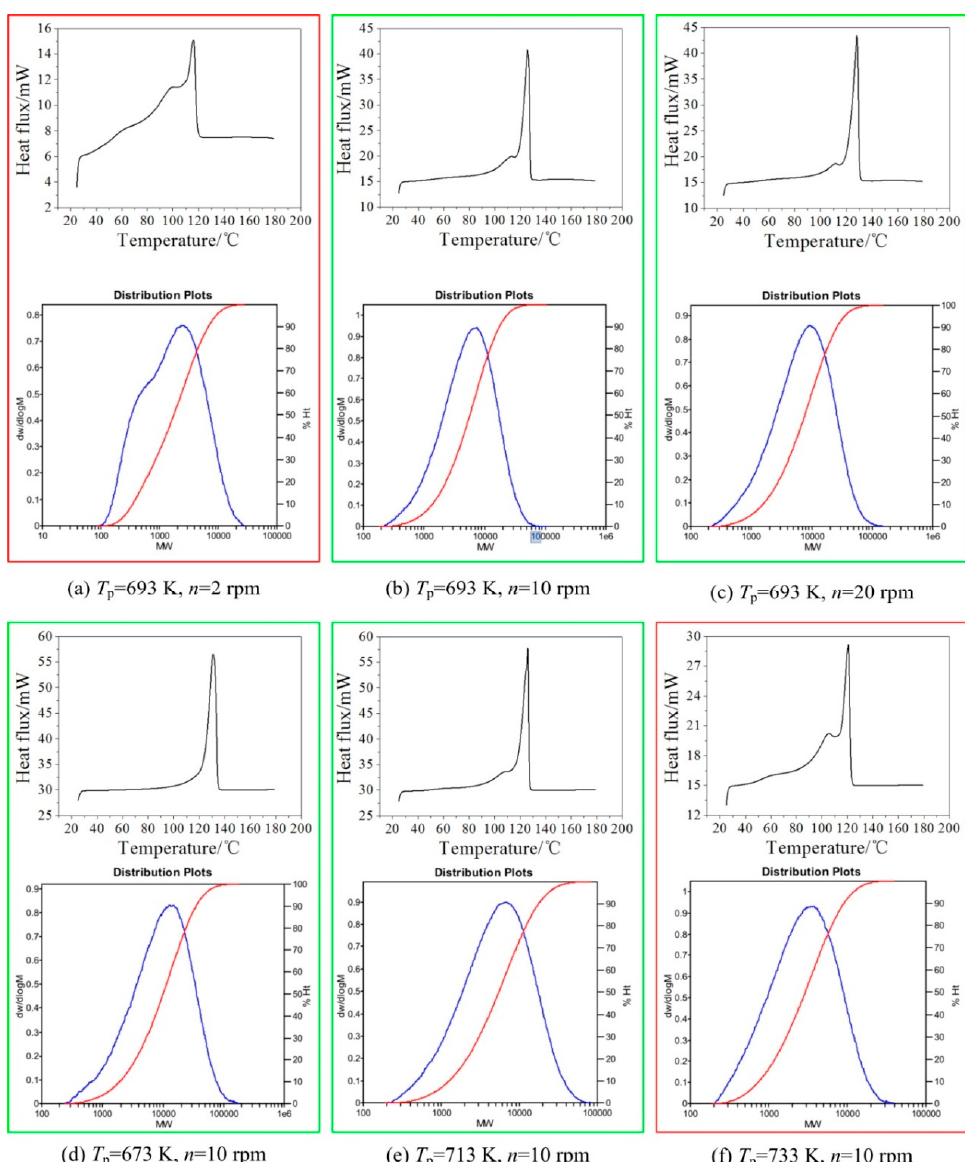
Figure 5. Differential scanning calorimetry ( DSC) curves and molecular weight distribution plots of PEWs under different screw speeds and pyrolysis temperatures. ( a ) T p = 693 K, n = 2 rpm, ( b ) T p = 693 K, n = 10 rpm, ( c ) T p = 693 K, n = 20 rpm, ( d ) T p = 673 K, n = 10 rpm, ( e ) T p = 713 K, n = 10 rpm, ( f ) T p = 733 K, n = 10 rpm.